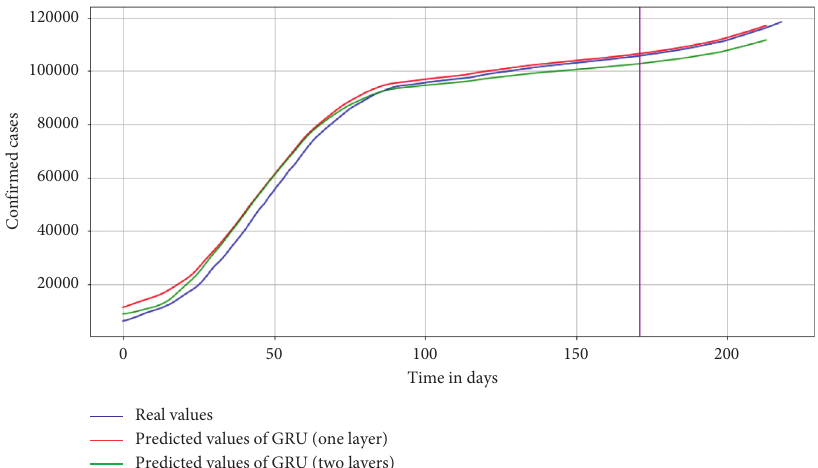
Figure 3: Comparison between real confirmed cases and the predicted confirmed cases for GRU